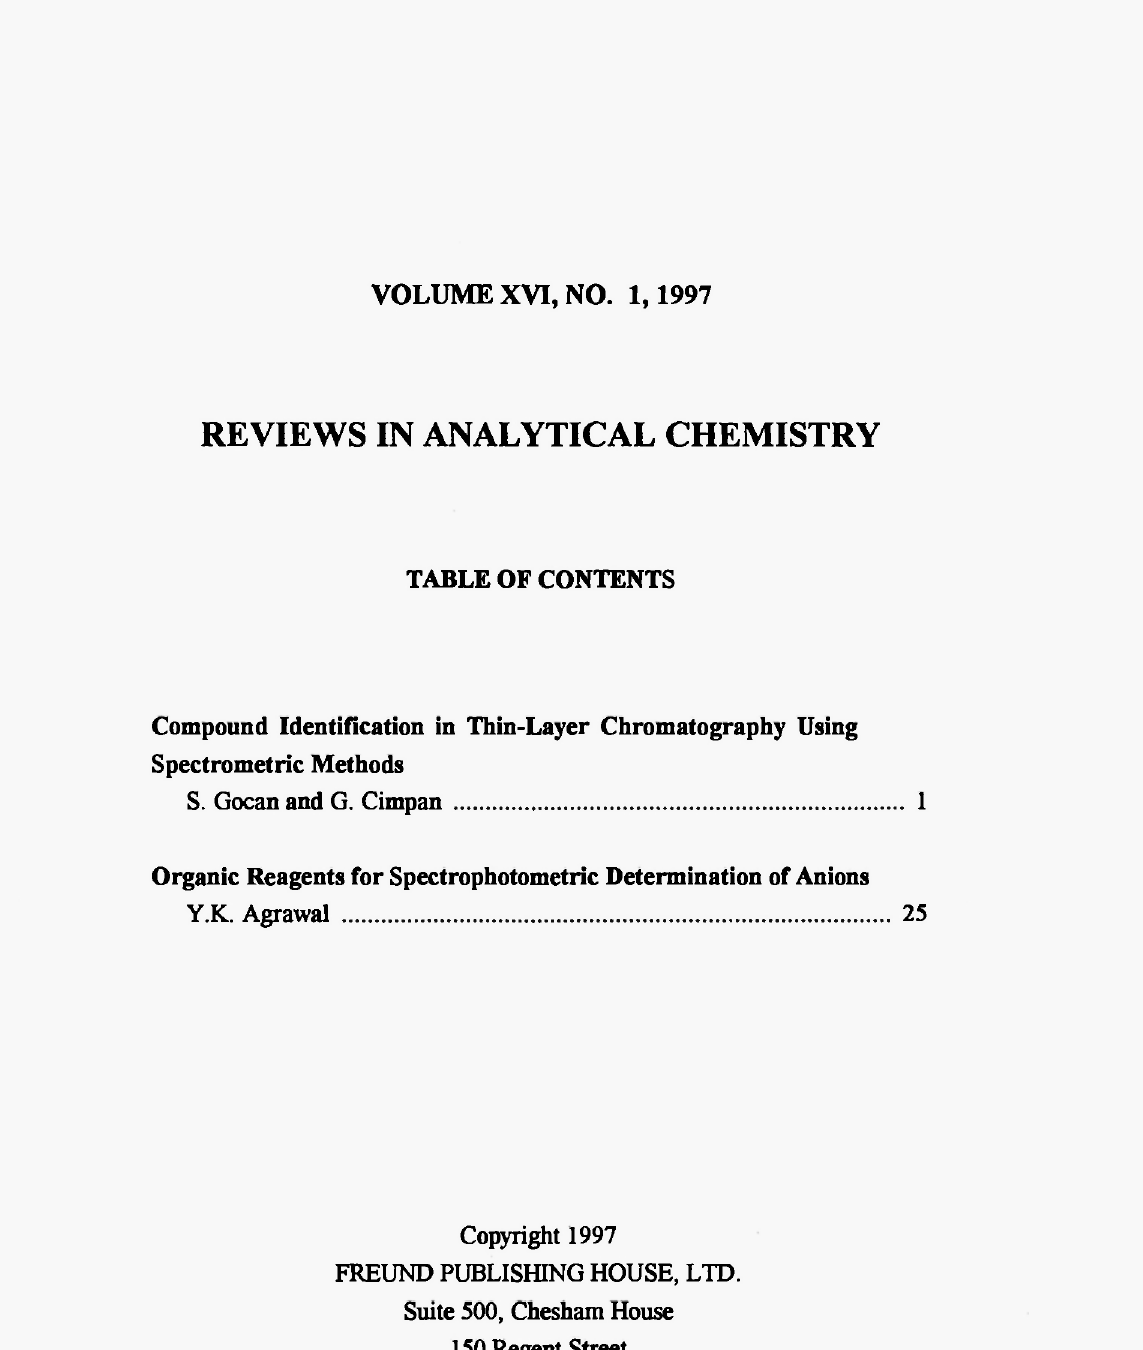
Organic Reagents for Spectrophotometric Determination of